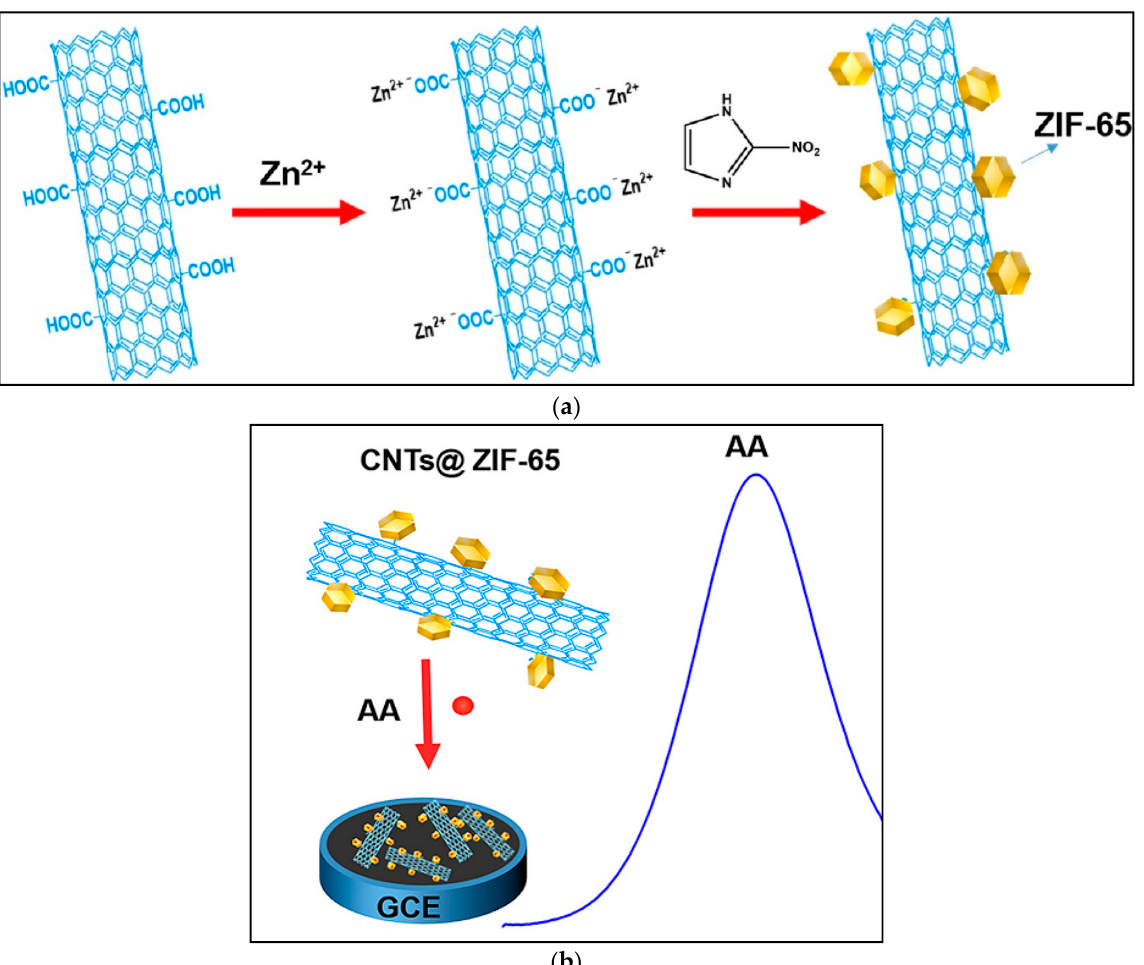
Figure 6. ( a ) Schematic illustration of the in-situ growing ZIF-65 MOFs on the surface of carboxylated CNTs; ( b ) GCE modification with this nanohybrid. Reproduced with permission from [126].